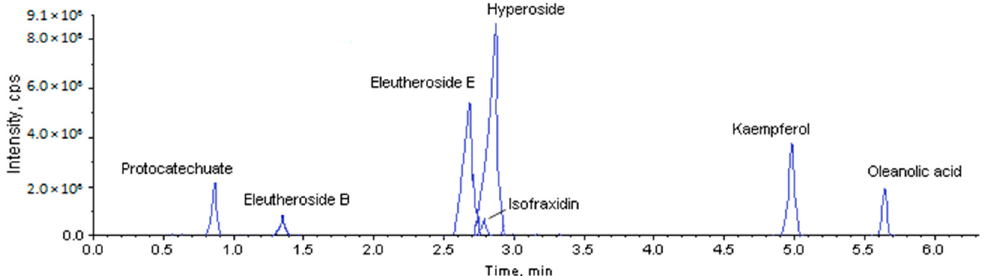
Figure 1. UPLC-MS chromatograms of 7 standard target compounds.